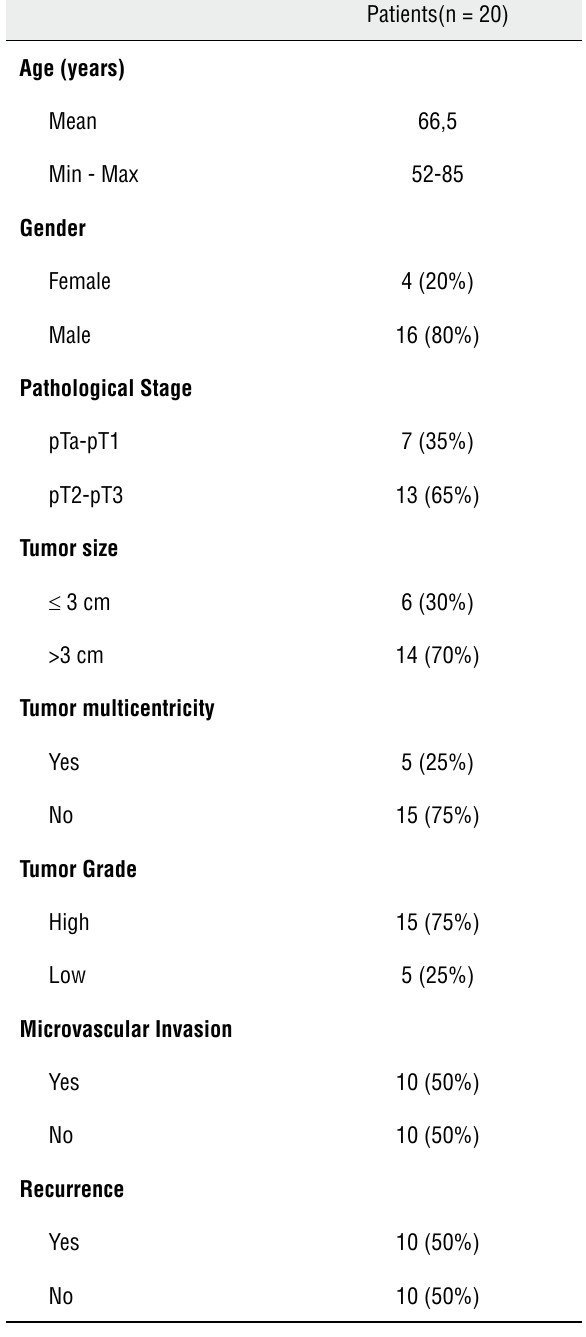
Table 1 - Patients characteristics.